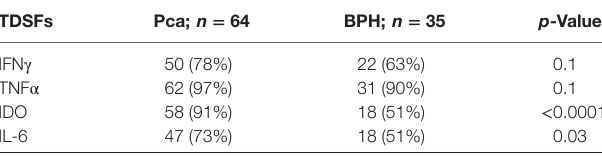
TaBle 1 | Distribution of tumor-derived soluble factors (TDSFs) gene expression in prostate cancer (PCa) and benign prostatic hyperplasia (BPH) tissues.